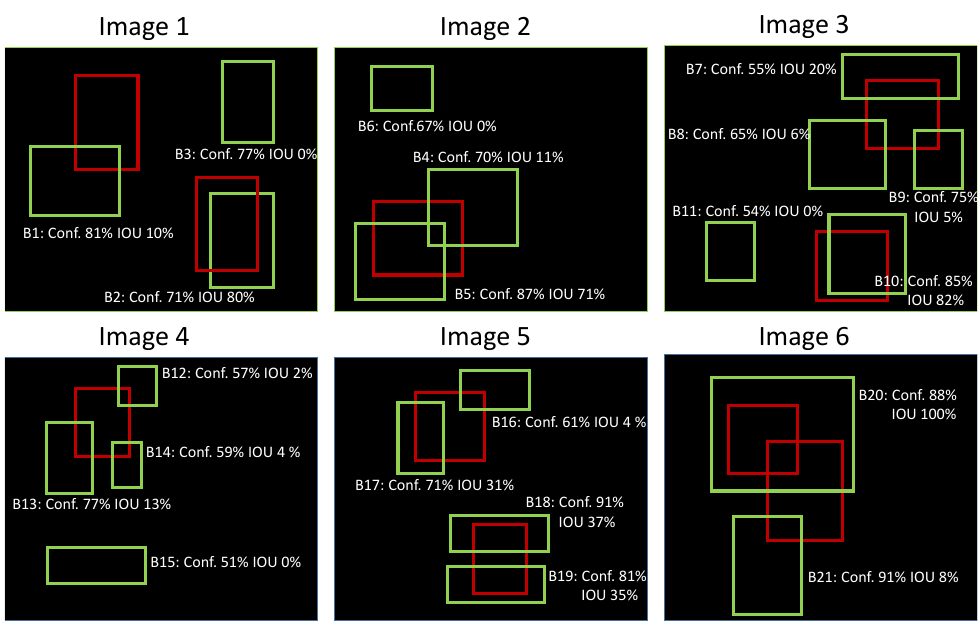
Figure 6. Example of how the precision–recall curve is generated for six different images. Red bounding boxes show ground truth objects while green bounding boxes indicate detected objects.